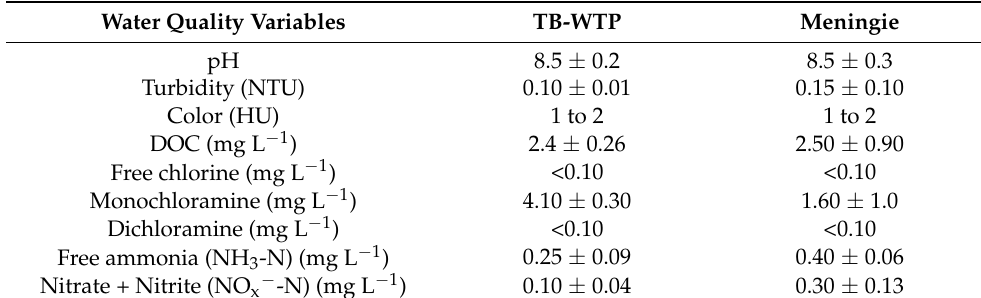
Table 1. The average value (mean ± 1 SD) of water quality parameters at the TB-WTP and the studied points in the distribution system. Water Quality